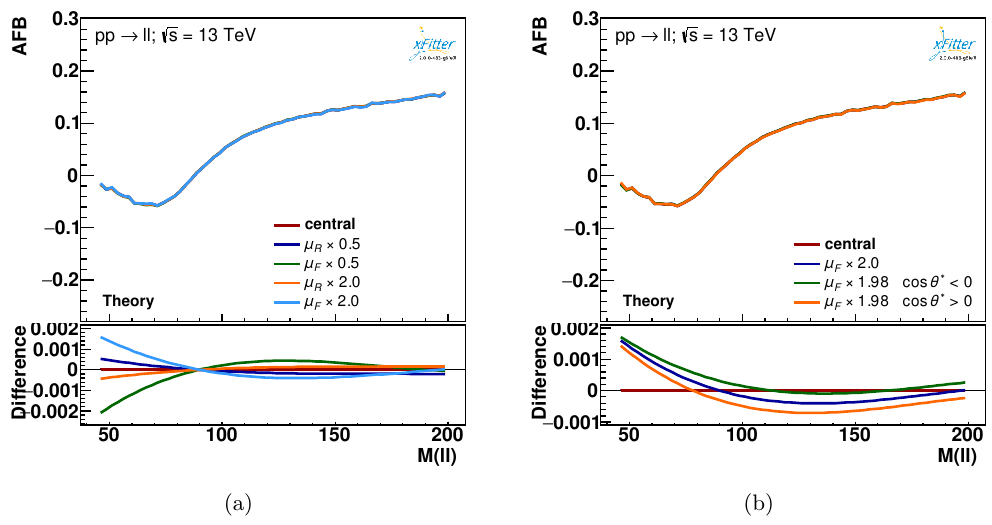
Figure 7 . (a) A FB predictions obtained with the HERAPDF2.0nnlo PDF set for some combinations of factorisation and renormalisation scales (top panel) and their deviations with respect to the central curve with (cid:22) F;R =M ‘‘ = 1 : 0 (bottom panel). (b) A FB predictions for the curve with (cid:22) F =M ‘‘ = 2 : 0 ; (cid:22) R =M ‘‘ = 1 : 0 in both APPLgrids with cos (cid:18) (cid:3) > 0 and cos (cid:18) (cid:3) < 0 (blue line) and with (cid:22) F =M ‘‘ = 2 : 0 ; (cid:22) R =M ‘‘ = 1 ; 0 for cos (cid:18) (cid:3) > 0 and (cid:22) F =M ‘‘ = 1 : 98 ; (cid:22) R =M ‘‘ = 1 : 0 for cos (cid:18) (cid:3) < 0 (green line) and with (cid:22) F =M ‘‘ = 1 : 98 ; (cid:22) R =M ‘‘ = 1 : 0 for cos (cid:18) (cid:3) > 0 and (cid:22) F =M ‘‘ = 2 : 0 ; (cid:22) R =M ‘‘ = 1 : 0 for cos (cid:18) (cid:3) < 0 (orange line) (top panel) and their deviations with respect to the central curve with (cid:22) F;R =M ‘‘ = 1 : 0 (bottom panel). For presentation purposes the curves in the bottom panels are smoothed using a cubic polynomial